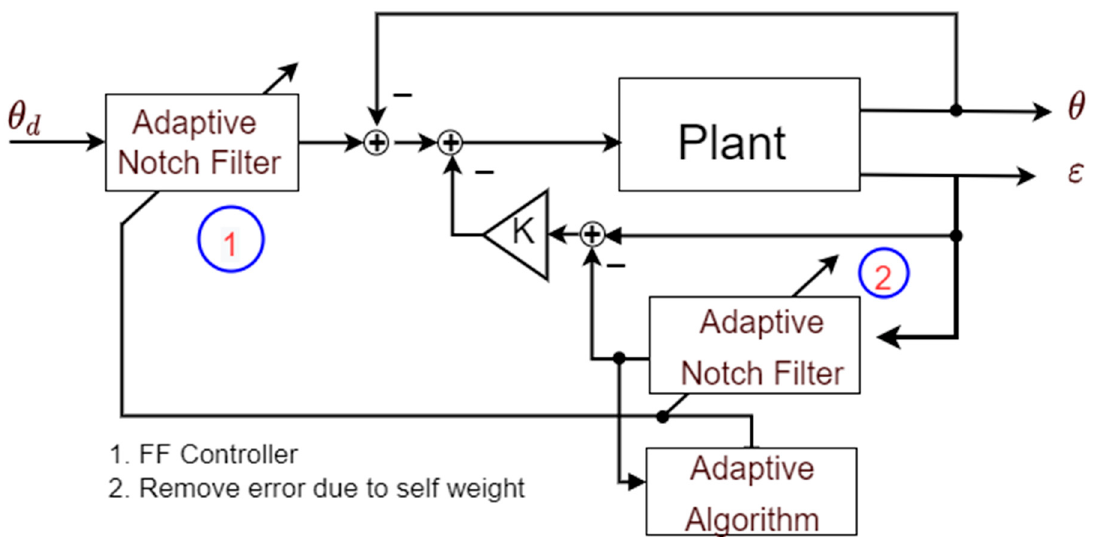
Figure 9. Block diagram of the adaptive notch filter feedforward control system.